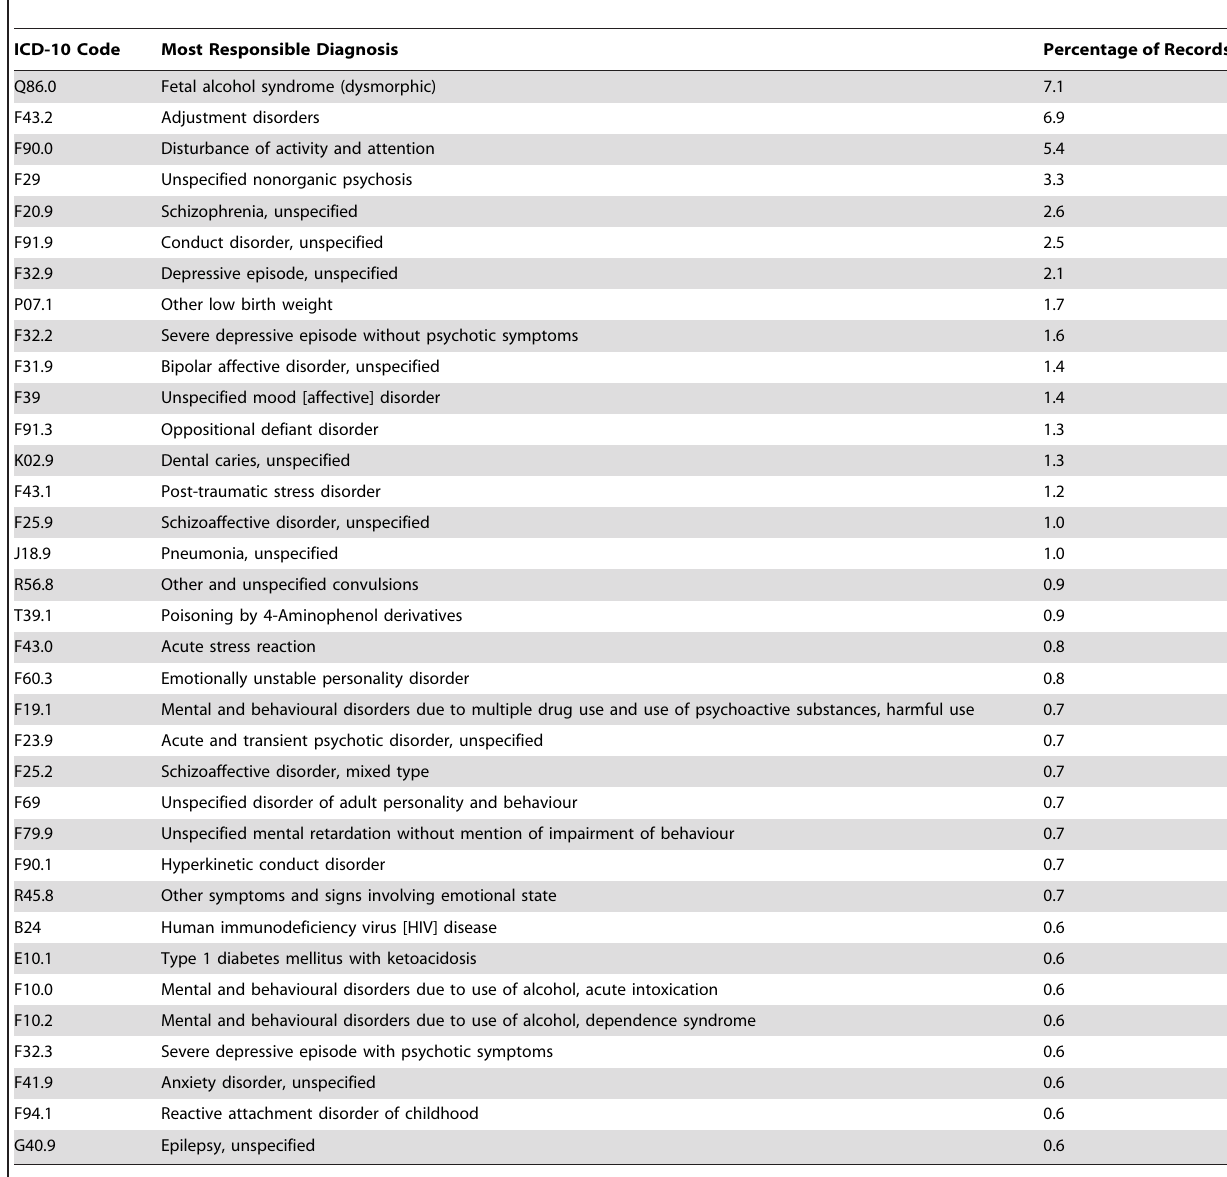
Table 3. Percentage of records of the top most responsible diagnoses (MRDs) among individuals diagnosed with FAS who used acute care, psychiatric care, day surgery, and emergency department services in Canada in